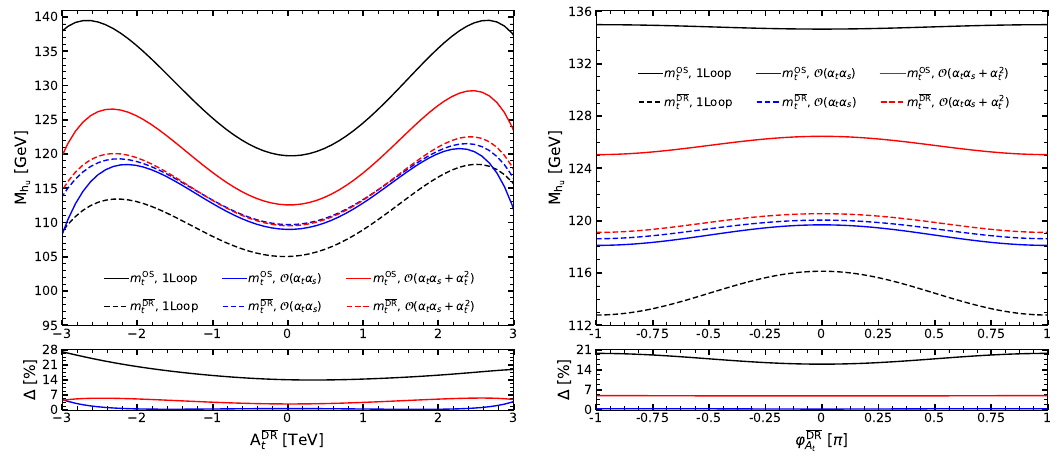
Figure 9 . Upper Panel: the mass of the h u -like Higgs boson at one-loop level (black/two outer lines) and at two-loop level including the O ( (cid:11) t (cid:11) s ) corrections (blue/two lower middle lines) and the O ( (cid:11) t (cid:11) s + (cid:11) 2 ) corrections (red/two upper middle lines) as a function of A DR (left) and ’ DR t t A t (right). Solid lines: OS, dashed lines: DR renormalization in the top/stop sector. Lower Panel: absolute value of the relative deviation of the result with OS renormalization in the top and stop sector with respect to the result using a DR scheme | i.e. (cid:1) = j M m t (DR) (cid:0) M m t ( OS ) j =M m t (DR) | h u h u h u in percent as a function of A DR (left) and ’ DR at two-loop O ( (cid:11) t (cid:11) s ) (blue/lower line), at two-loop t A t O ( (cid:11) t (cid:11) s + (cid:11) 2 ) (red/middle line) and one-loop order (black/upper t